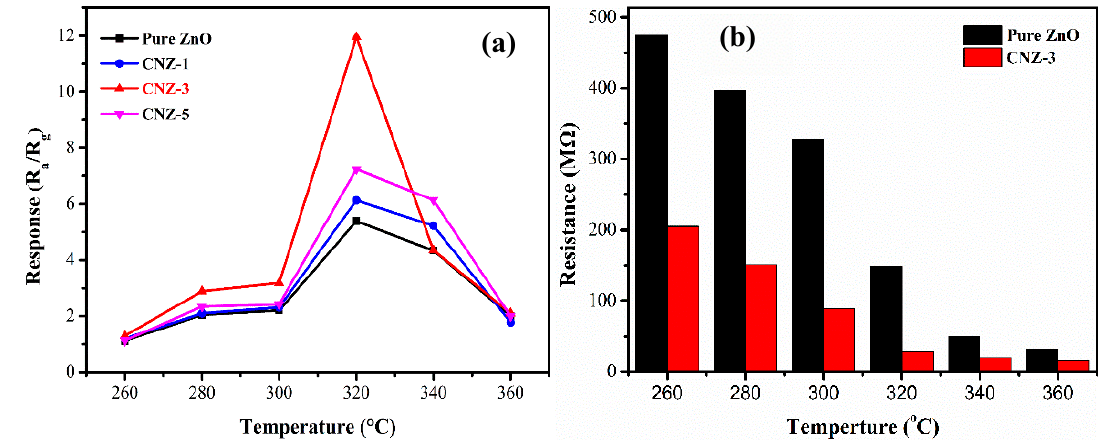
Figure 8. ( a ) The temperature-dependent response of the sensors to 1000 ppm CH 4 ; ( b ) the resistances in air (Ra) of the pure ZnO and CNZ-3 sensors at different operating temperatures.